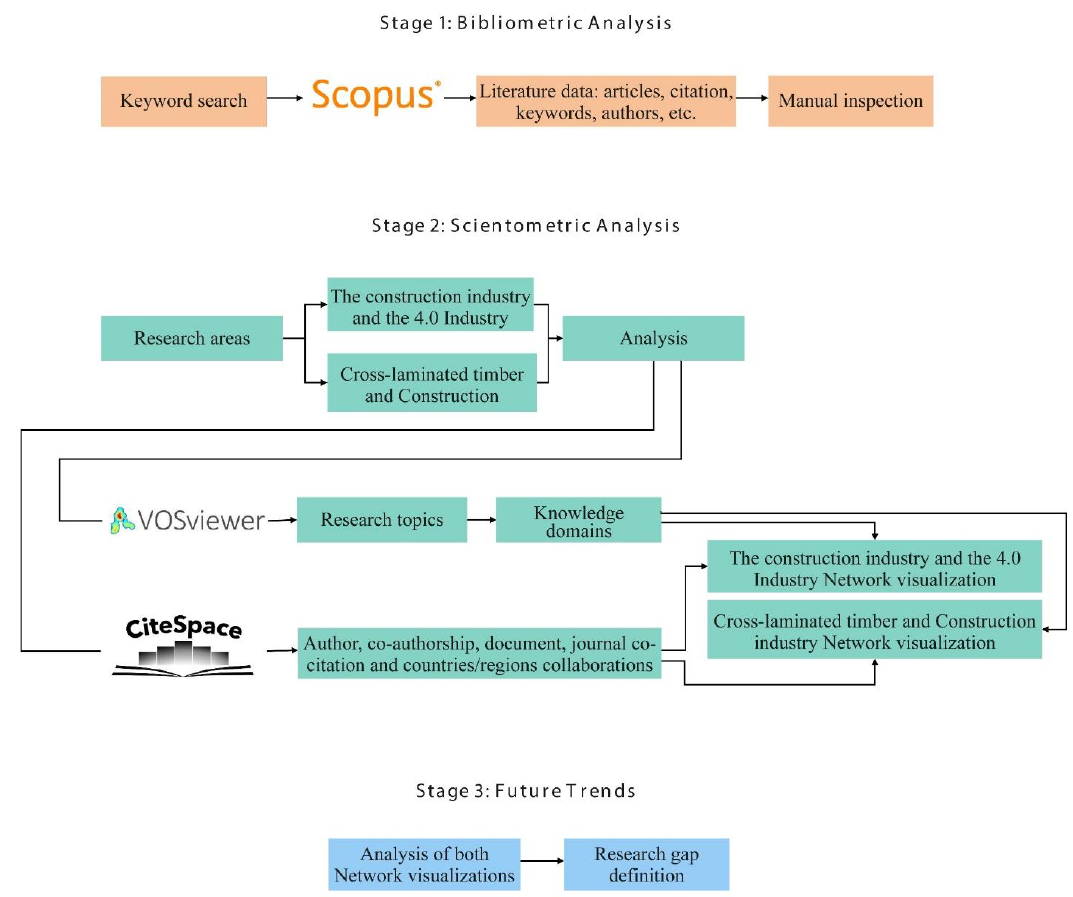
Figure 1. Overall view of the suggested research methodology.